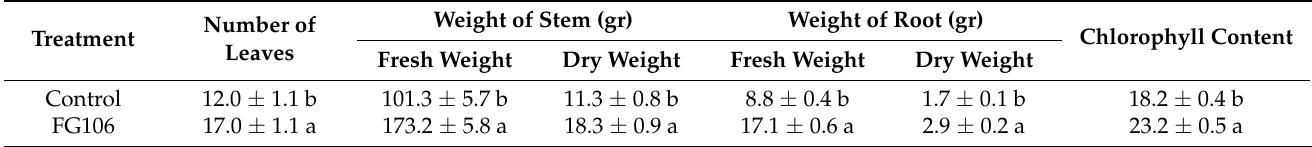
Table 5. Effects of P. aeruginosa strain FG106 on root and stem weight, number of leaves, and chlorophyll content of tomato plants under greenhouse